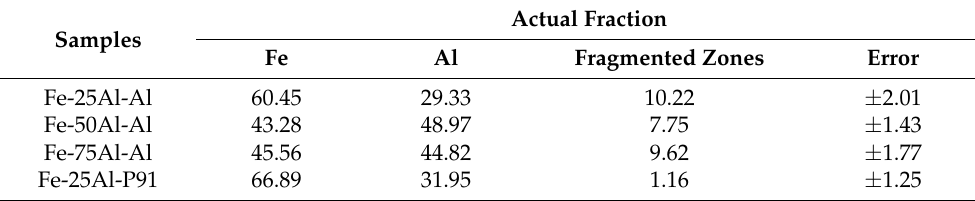
Figure 5. SEM image ( a ) and EDS elemental mapping analysis ( b – d ) of an Fe particle attached to many Al particles in the fracture morphology. Table 2. Actual fraction of Fe, Al and fragmented zones in Fe/Al coatings